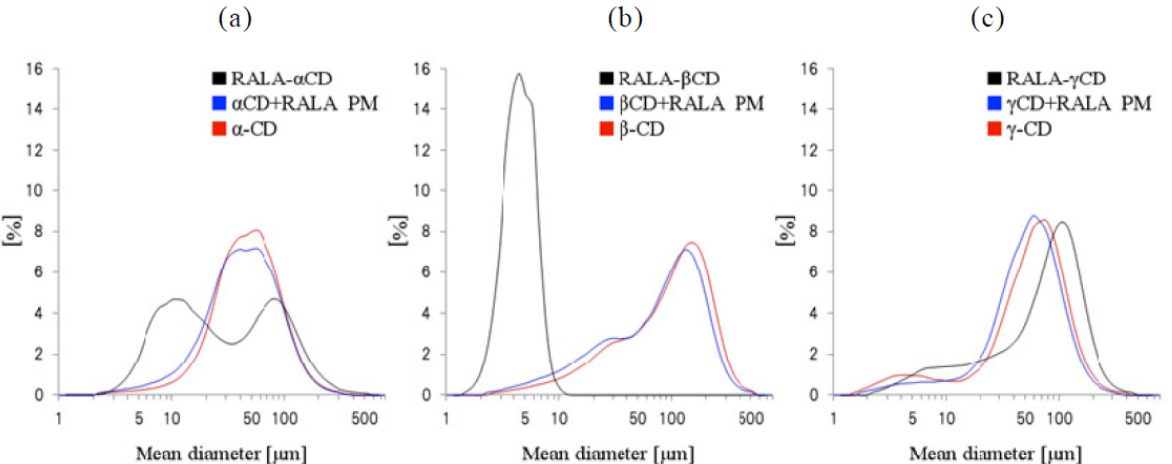
Figure 6. Particle size distributions of the RALA- α CD, - β CD and - γ CD complexes, their physical mixtures (PM) and CD. ( a ) α -CD, physical mixture and RALA- α CD, ( b ) β -CD, physical mixture and RALA- β CD and ( c ) γ -CD, physical mixture and RALA- γ